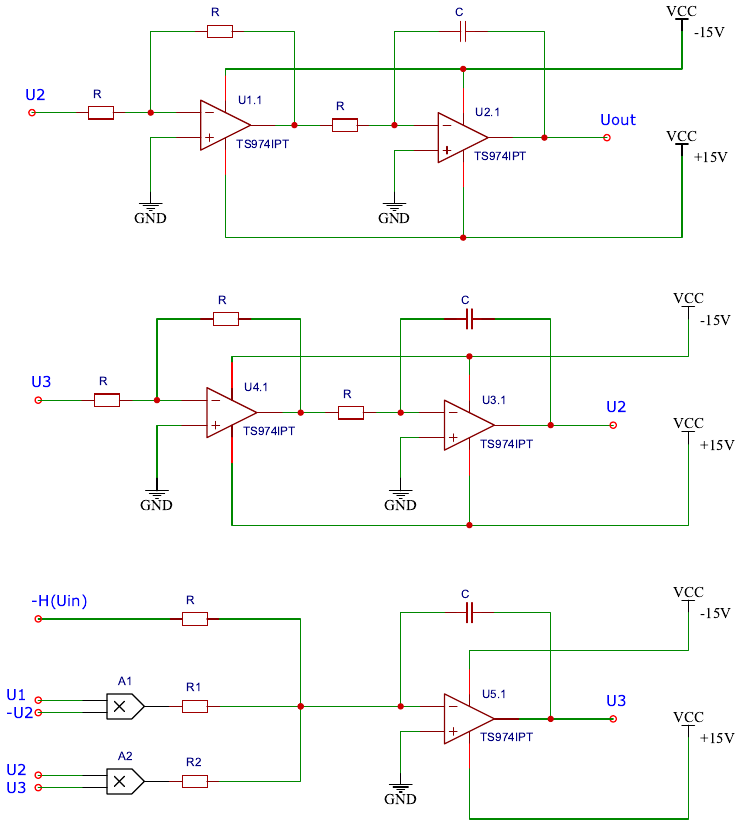
Figure 6. Circuit